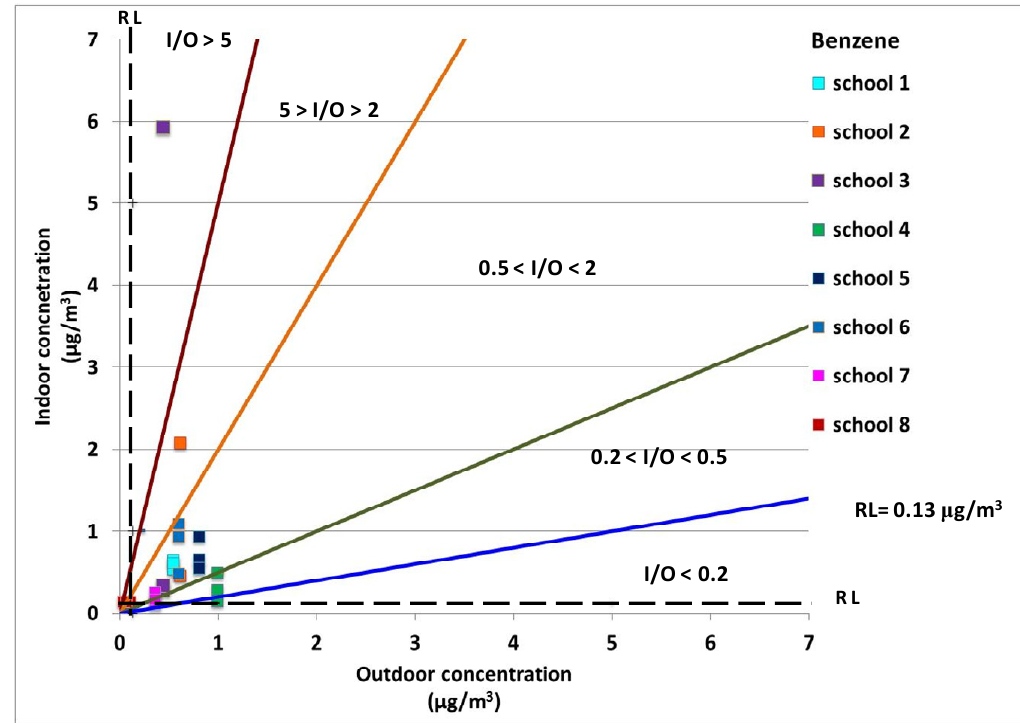
Figure 1. Benzene indoor concentrations against outdoor concentrations in all monitored sites. The reference level (RL) and five different I/O ranges were also displayed.